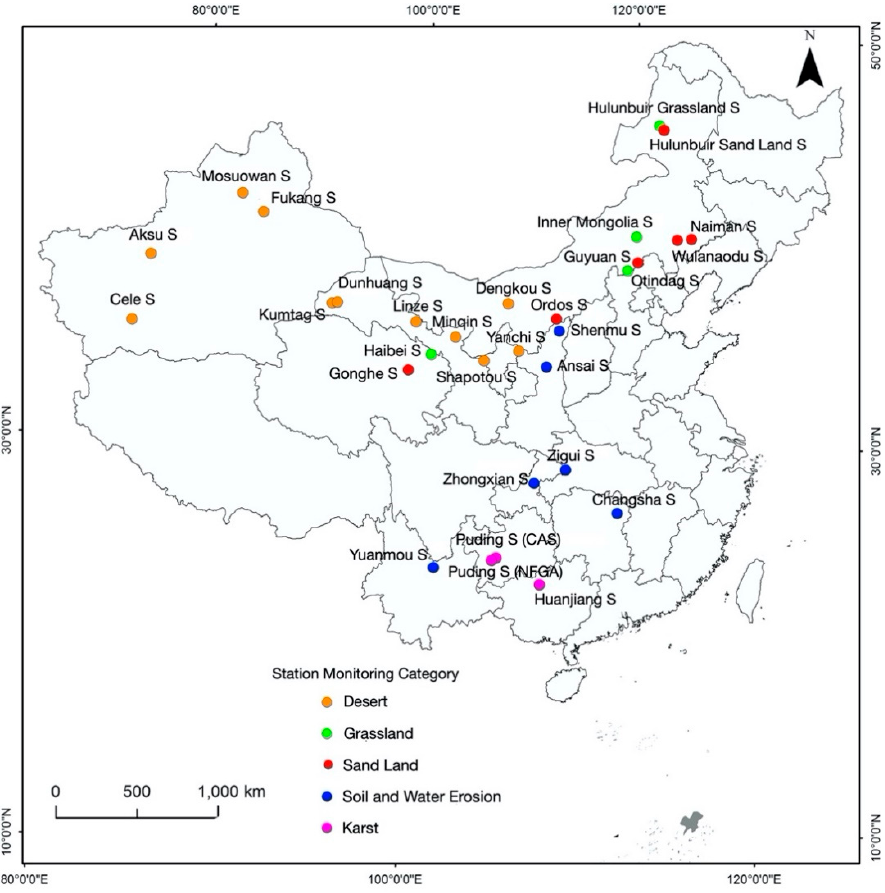
Figure 2. Field station network to support LDN in China (adapted from Lu et al., 2020) [136]. In 2017, China’s National Report of the Voluntary Land Degradation Neutrality (LDN) Target Setting Programme was published, indicating the extension and expansion of national programmes and increased funding of dryland research and planning [137].